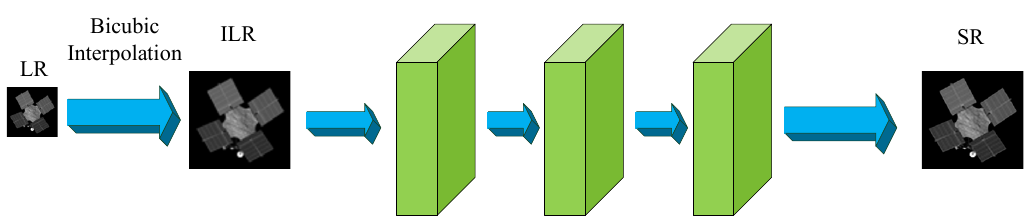
Figure 1. Network structure of SRCNN used in this paper. ILR, interpolated low-resolution image.